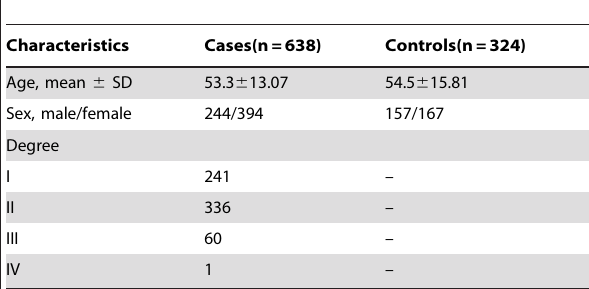
Table 1. Characteristics of the KBD cases and controls.